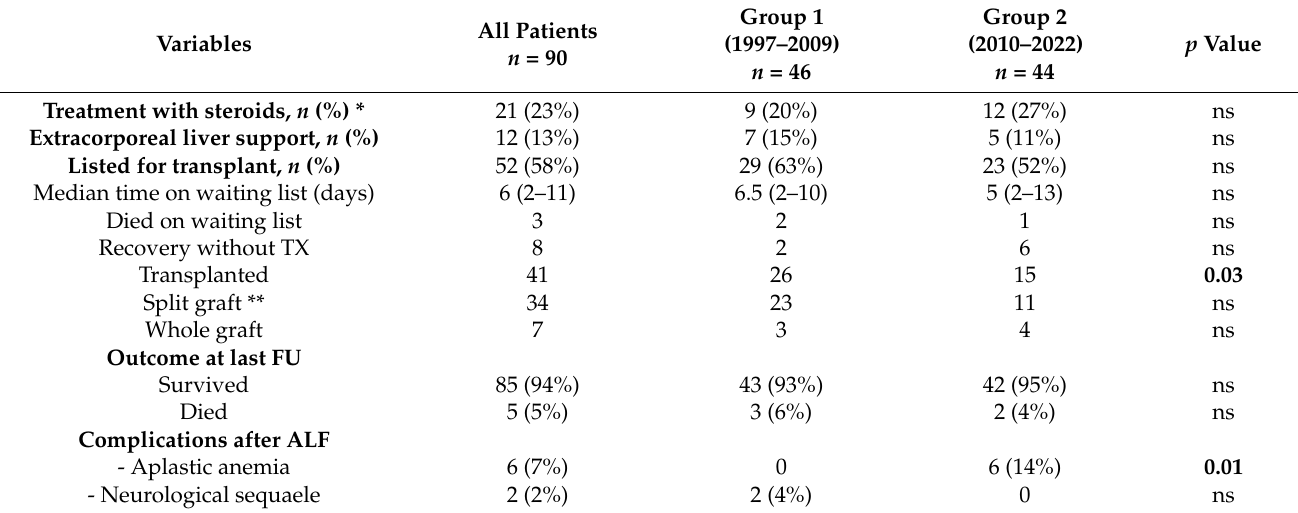
Table 2. Treatment and outcome in 90 children with ALF, comparison between two